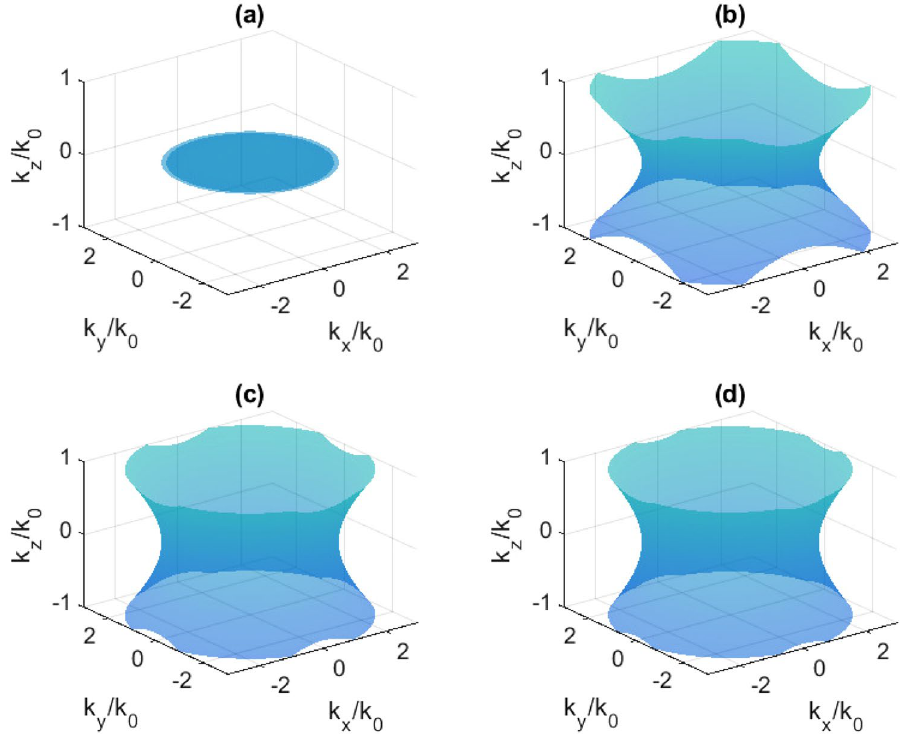
Figure 7. Isofrequency surfaces at 0.560 THz: ( a ) without pumping; ( b ) at 200 mW; ( c ) 400 mW; ( d ) 600